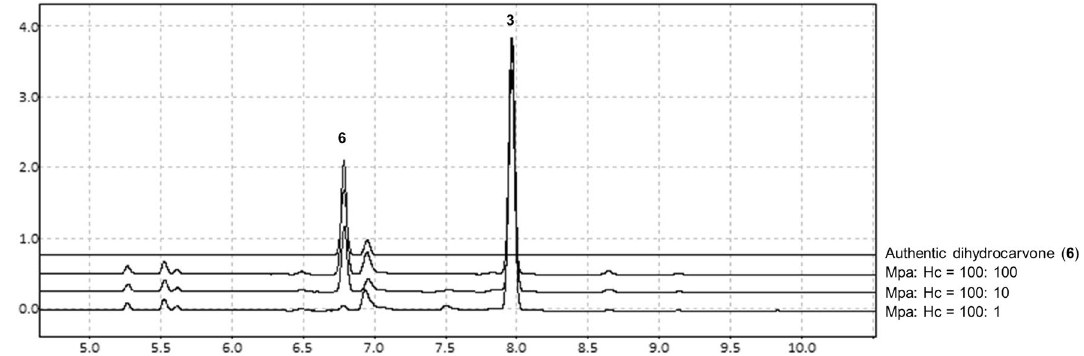
Figure 4. Optimization of enzyme balance by mixing two strains expressing P450/CPR and CDH enzymes. Strains expressing P450 and CPR (Mpa strain; BL21(DE3) pCDF-CYP71D18-ATR2) or CDH (Hc strain; BL21(DE3) pET-ISPD) were mixed in various ratios to determine the optimum balance for converting (−)-limonene to (−)-carvone. Varied P450/CDH input results in different (−)-carvone (3) production together with by-product dihydrocarvone (6)